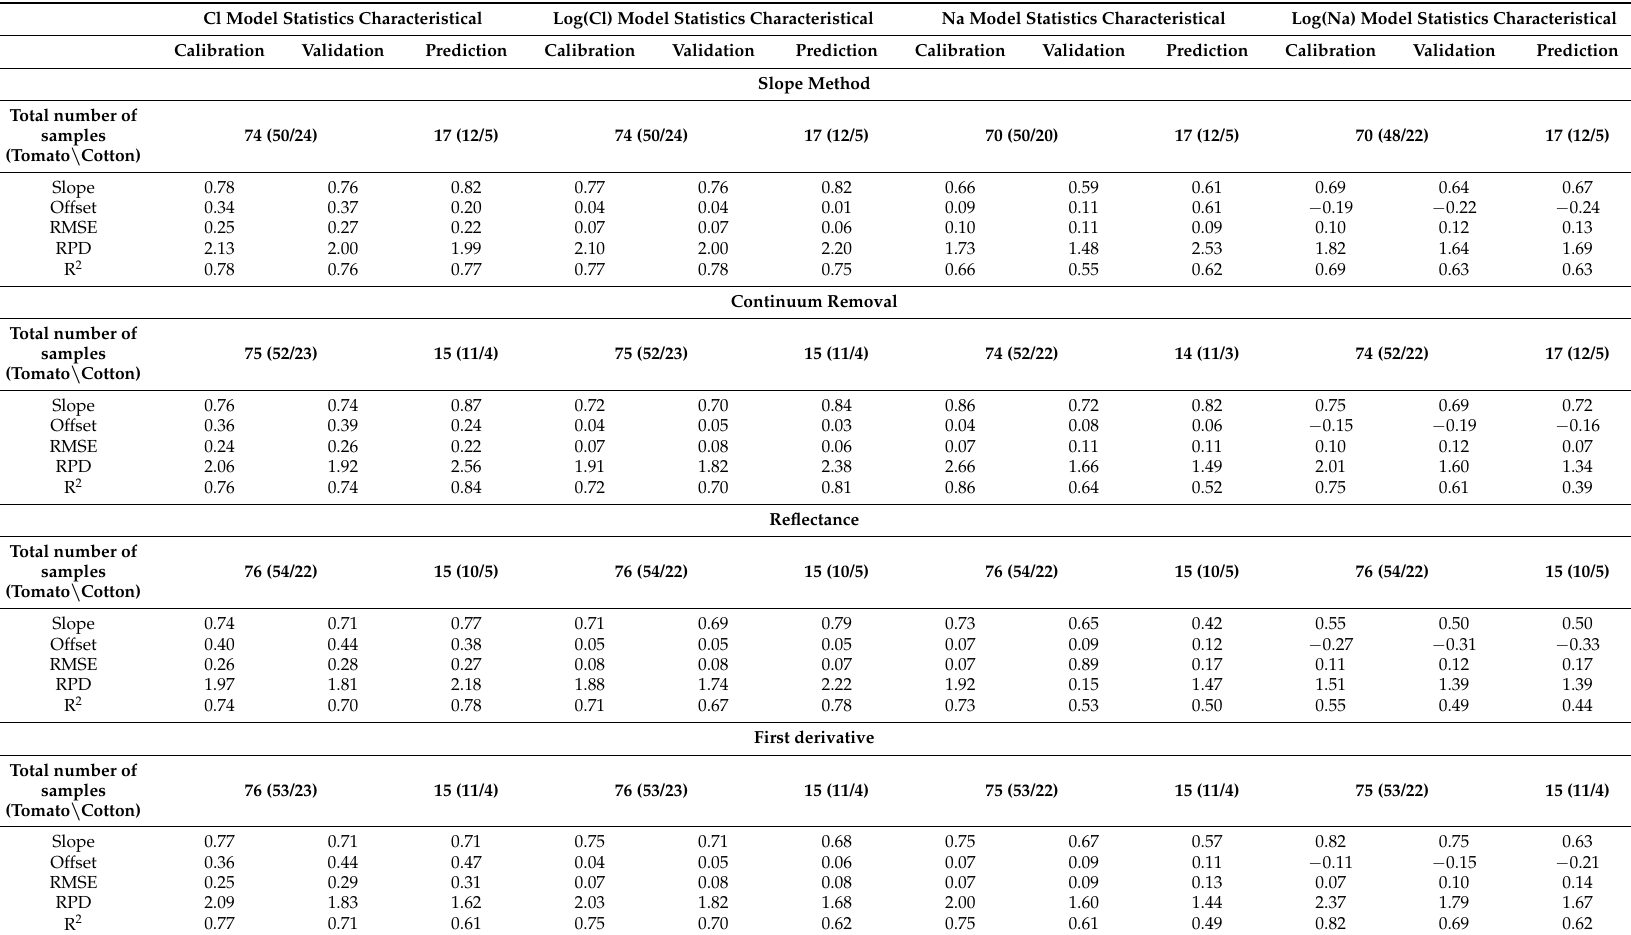
Table 4. Partial least squares (PLS) regression model results of slope method and of various data pre-processing techniques to assess Cl and Na in fresh vegetation